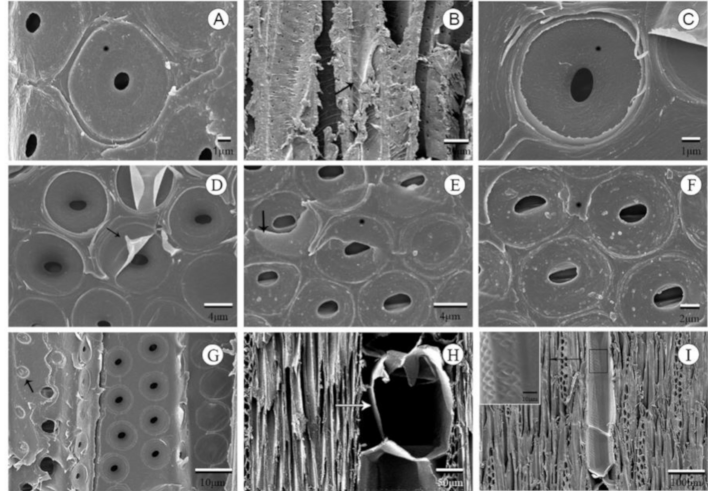
Figure 2. SEM photos of tangential surfaces of wood samples from sapwood ( A , B ), transition wood ( C , D ) and heartwood ( E – I ) of C. bungei . Warty layers and amorphous deposition were very rare in the pit chambers of sapwood (A), but became frequent in both the transition zone and heartwood (asterisks in C , E , F ). Helical thickenings were common in vessel walls of latewood ( B ). Pit membrane appeared to be thicker in heartwood compared with the transition zone ( D , E ). Tyloses occluded pit apertures and vessel chambers ( G – I ). Arrows point to pit membranes in transition wood and heartwood ( D , E ), pit chambers occluded by amorphous deposition ( G ) and tyloses in the vessel chambers ( H , I